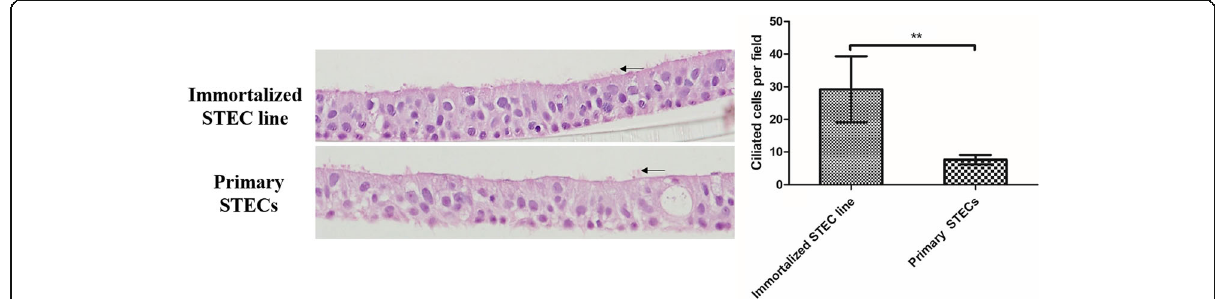
Fig. 4 Histological examination of immortalized STEC line and primary STECs cultured under Ali conditions. At D14, the cultures were fixed with 4% polyoxymethylene, then followed by histological sectioning and H&E staining. Ciliogenesis was assessed by counting the number of ciliated cells per randomly chosen microscope field (400 × magnification). Data are given as the mean +/ − SD of three microscope fields per culture and three independent cultures ( n = 9). (* P < 0.05, ** P <